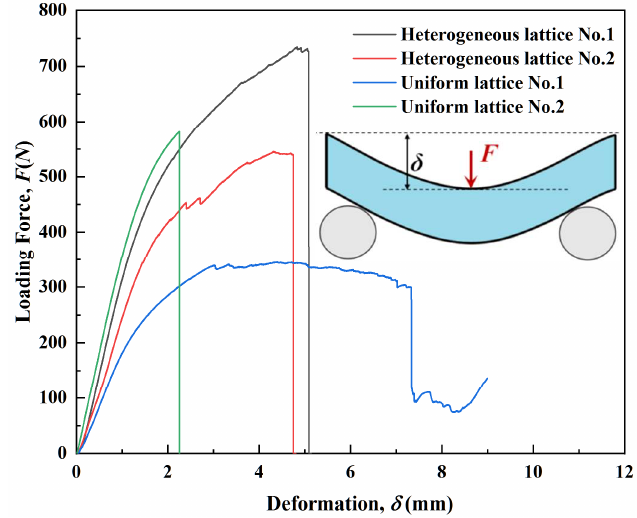
Figure 9. The bending load–displacement curves of the four lattice structures.